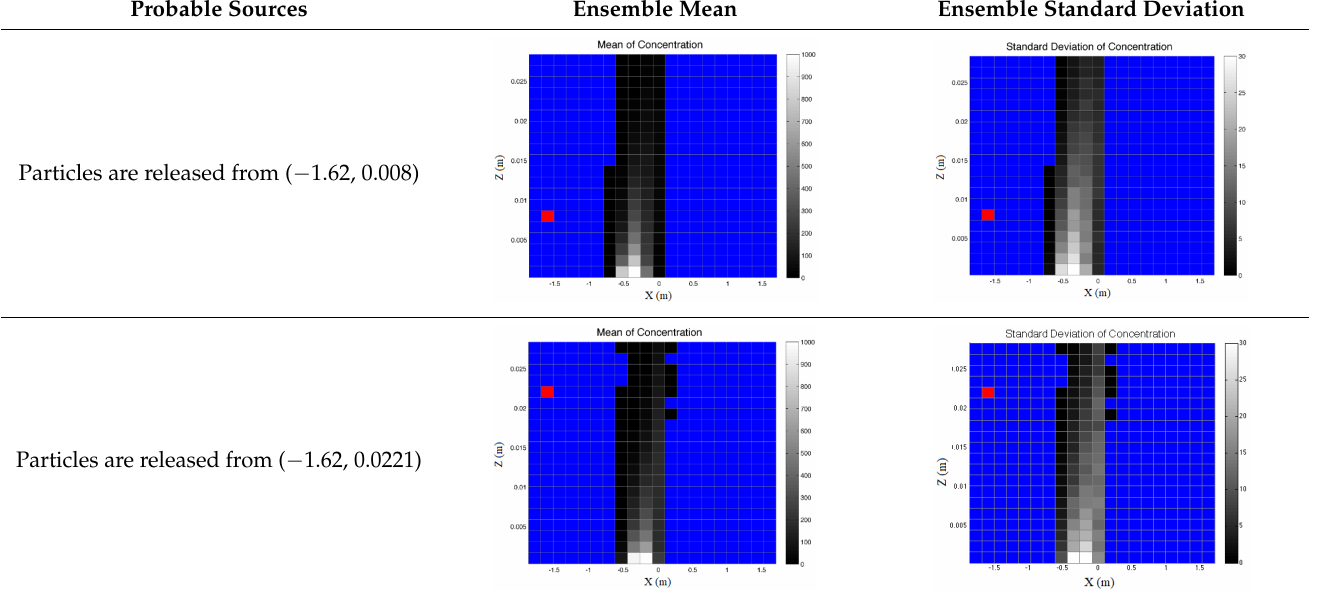
Table 6. Ensemble mean and ensemble standard deviation of the spatial sediment concentration distribution. Probable